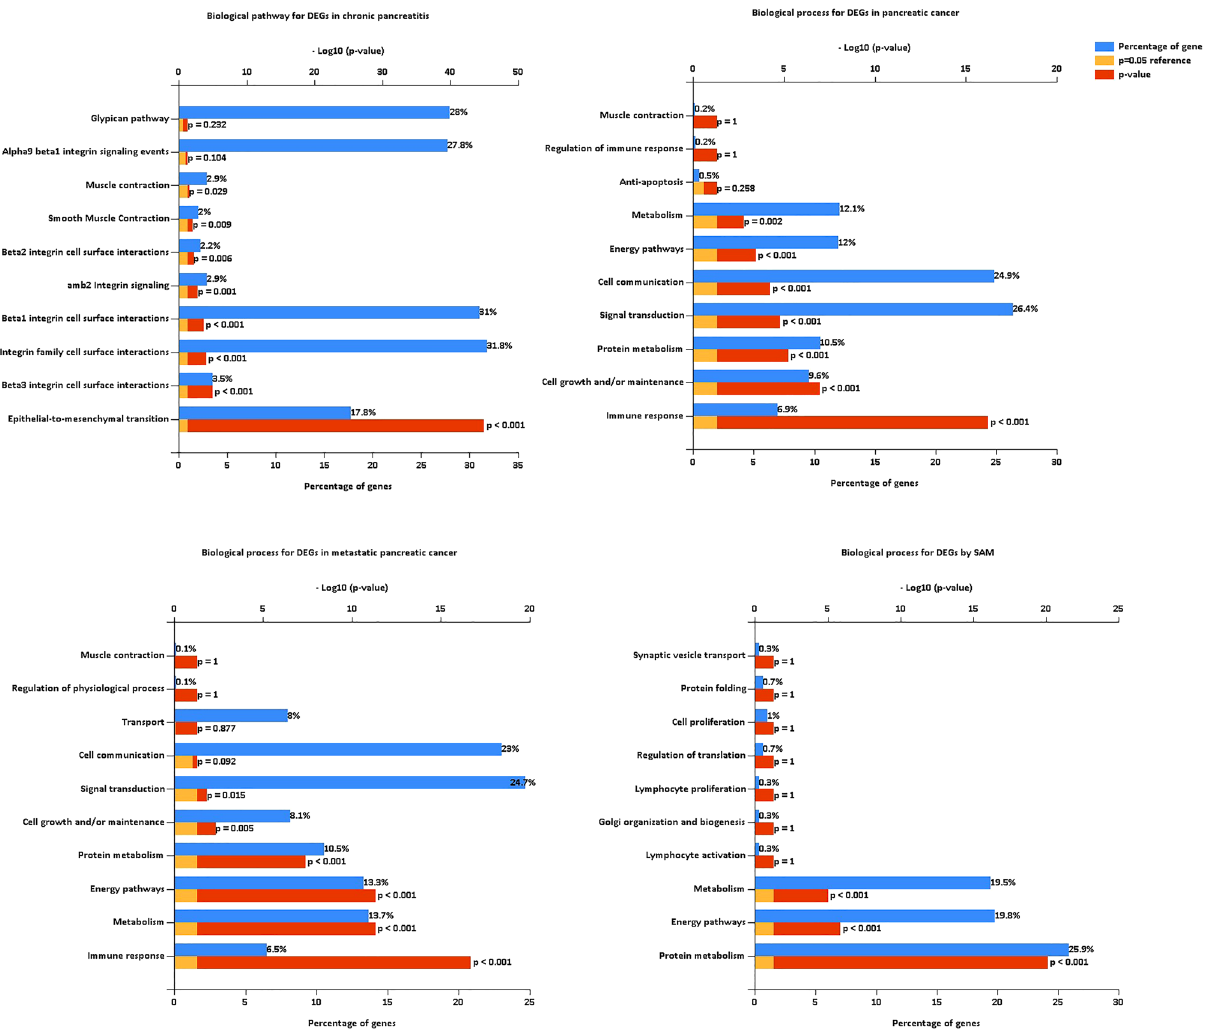
Figure 3. GO biological process for DEGs of chronic pancreatitis, pancreatic cancer, metastatic pancreatic cancer, and SAM,